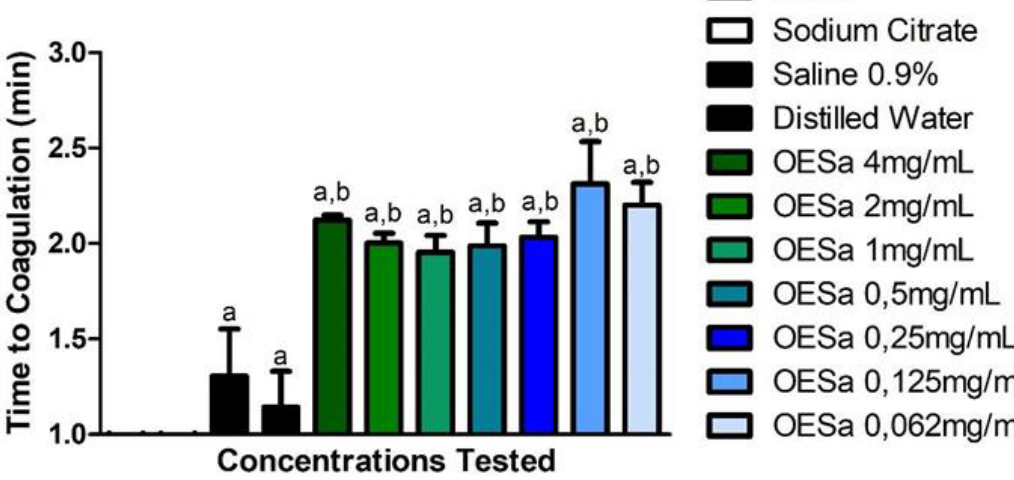
Figure 1. Anticoagulation potential of S. aromaticum essential oil. a p < 0.0001 compared to coagulant compounds (ethylenediaminetetraacetic acid (EDTA) and sodium citrate); b p < 0.001 compared to non-anticoagulant compounds (saline 0.9% and distilled water), one-way ANOVA.